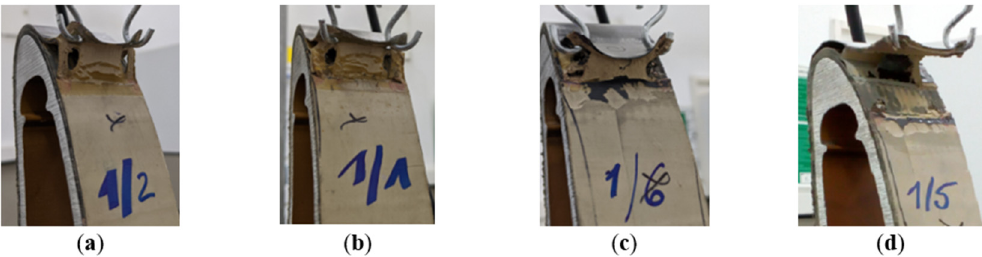
Figure 18. Characteristics of fractures during tests of the tearing off of the shield from the leading edge: ( a ) Factory bonding sample without aging, ( b ) Factory bonding sample after aging, ( c ) Bonding DP490 sample without aging, ( d ) Bonding DP490 sample after aging.